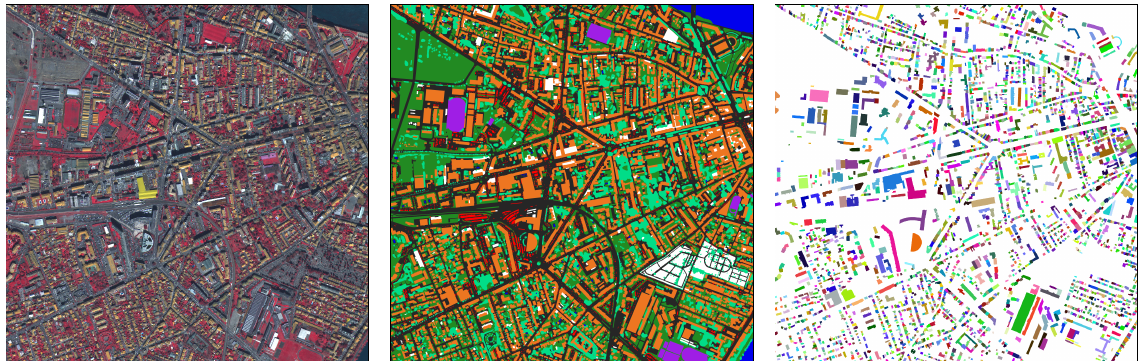
Figure 1. 1 out of 16 tiles of the SemCity Toulouse data set ( 876 px × 863 px , area covered ≈ 3km 2 ). Illustrated are the satellite image (near infrared-green-blue), semantic segmentation annotation, and building instance annotation (from left to right). than 200.000 300 px × 300 px tiles, but only in